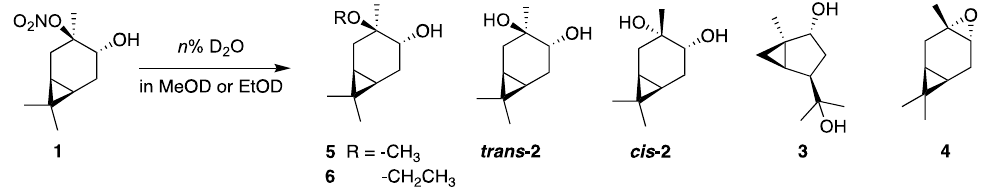
Figure 2. 1 H NMR spectra of CHN 1 reactions in ( a ) 50%; ( b ) 25%; and ( c ) 0.6% D 2 O/DMSO- d 6 mix- tures.